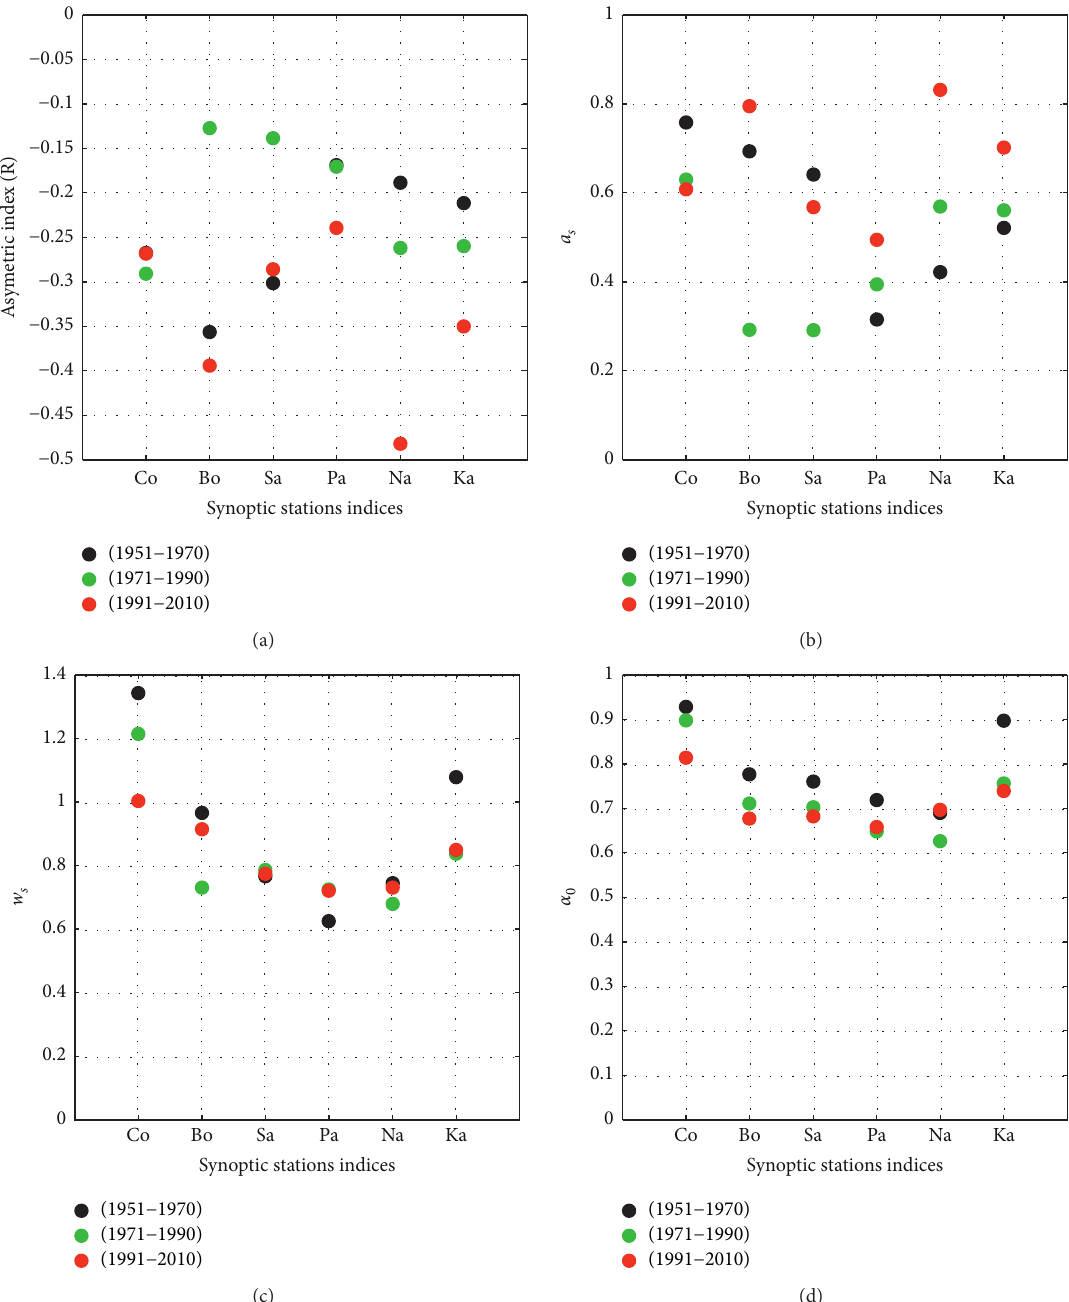
Figure 8: Spatiotemporal variation of the asymmetry index values (R) and the multifractal spectrum parameters ( a precipitation data. Co, Bo, Sa, Pa, Na, and Ka mean Cotonou, Bohicon, Save, Parakou, Natitingou, and Kandi synoptic stations, respectively. The spatiotemporal variation of (R) a s , α , and w are shown at panels (a), (b), (c), and (d), 0